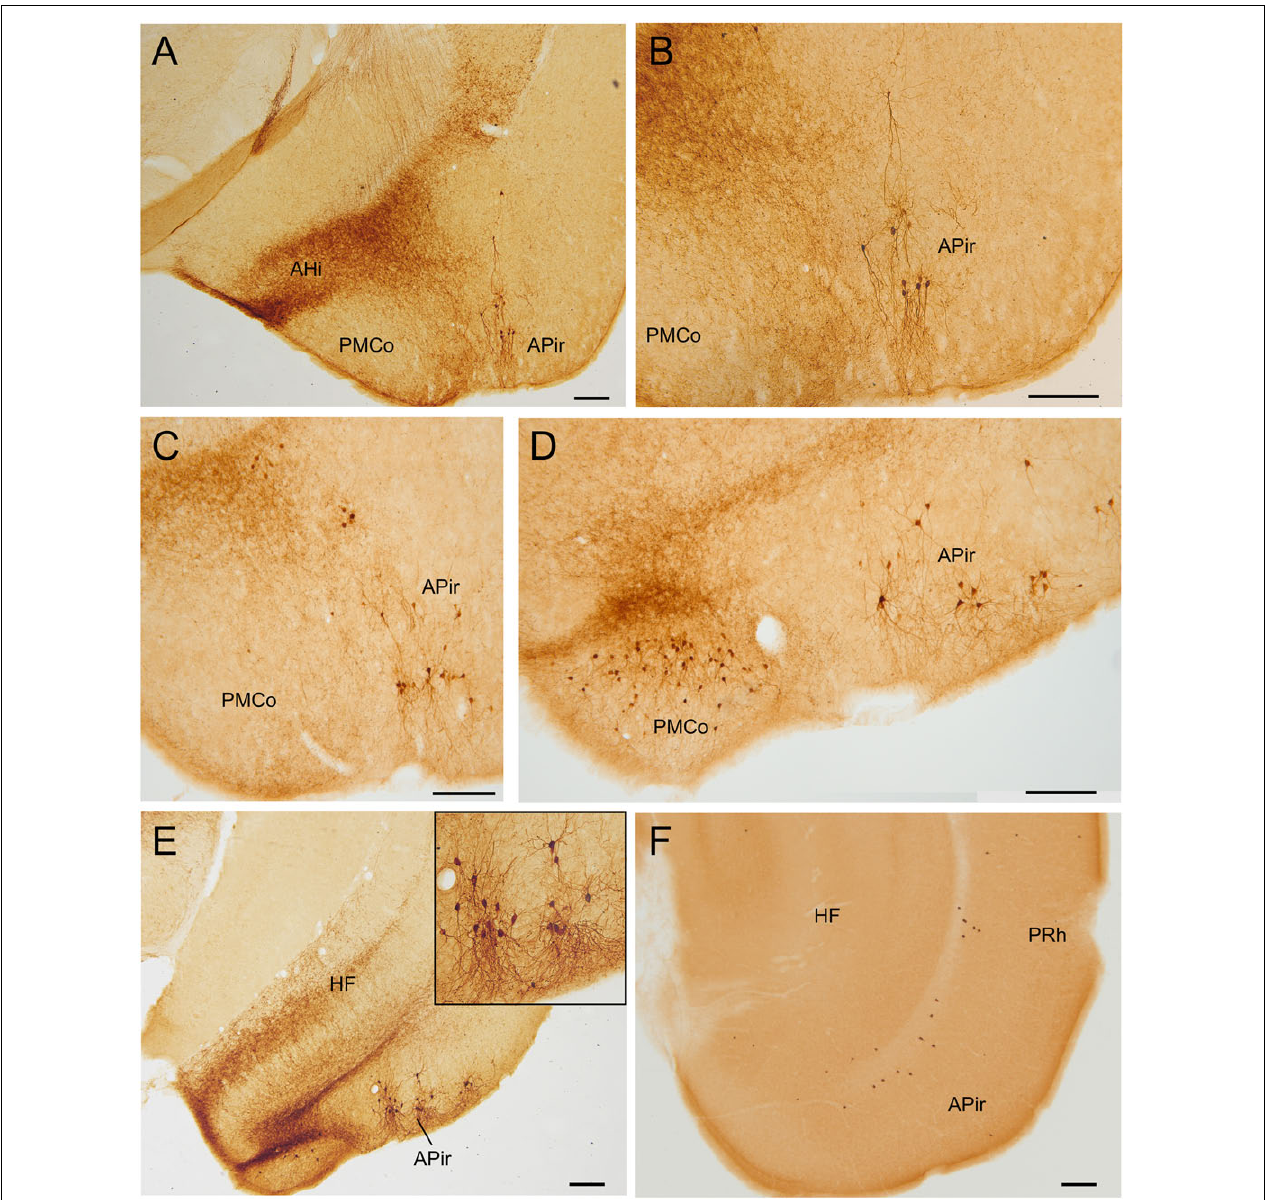
FIGURE 5 | GFP and HA immunoreactivity at posterior levels of the adult amygdala. Images of frontal brain sections of adult Otp-eGFP mice (A–E) and Otp-Cre; Rpl22-HA mice (F) , showing GFP or HA immunoreactive cells in the posterior cortical amygdalar area (in particular PMCo) and adjacent amygdalo-piriform transition area (APir). Dense neuropil is also observed in the amygdalo-hippocampal area (AHi) and adjacent hippocampus. In the Otp-Cre; Rpl22-HA, labeled cells are also observed in similar positions (such as APir), but most of them occupy a deeper stratum than in the Otp-eGFP. See text and abbreviation list for more details. Scale bar: panels (A–F) = 200 µ